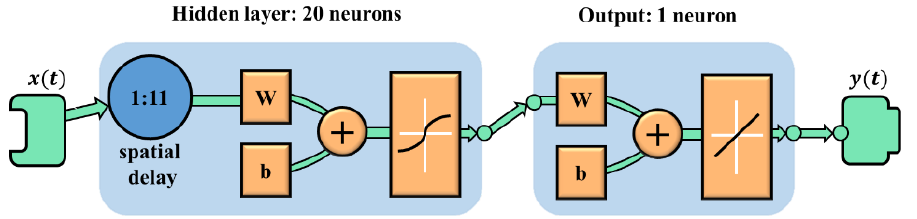
Figure 15. The training process of the NARNN.